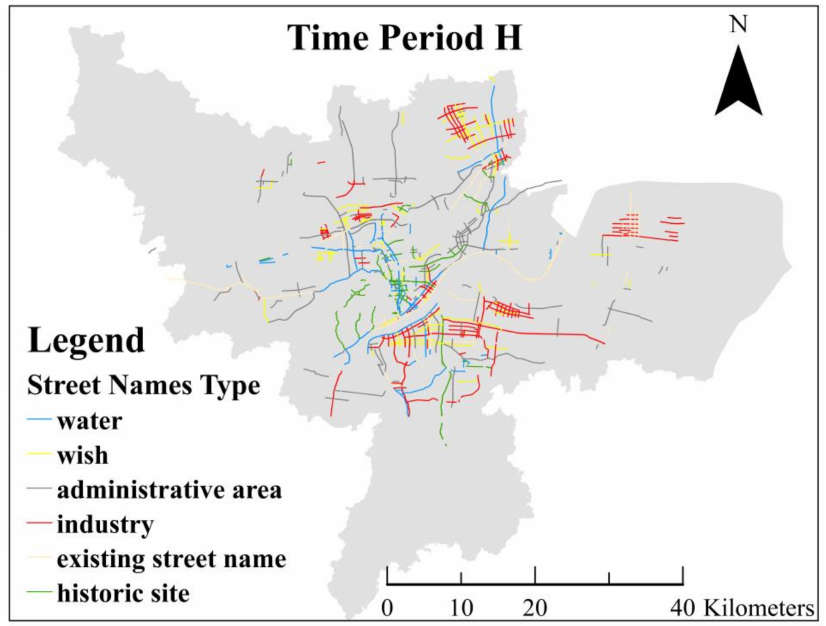
Figure 9. The spatial distribution of main types of street names in time period H.